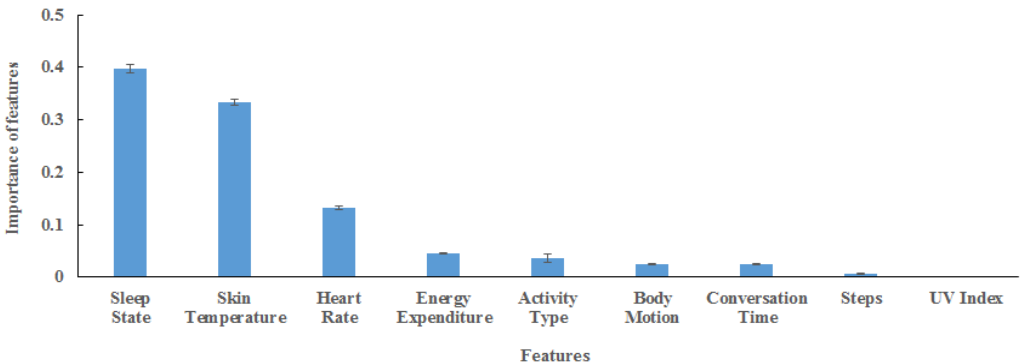
Figure 2. Importance of features in RF. Values of importance of features are mean and standard deviation of 4 segments. Table 2. Detection accuracy for each classifier.